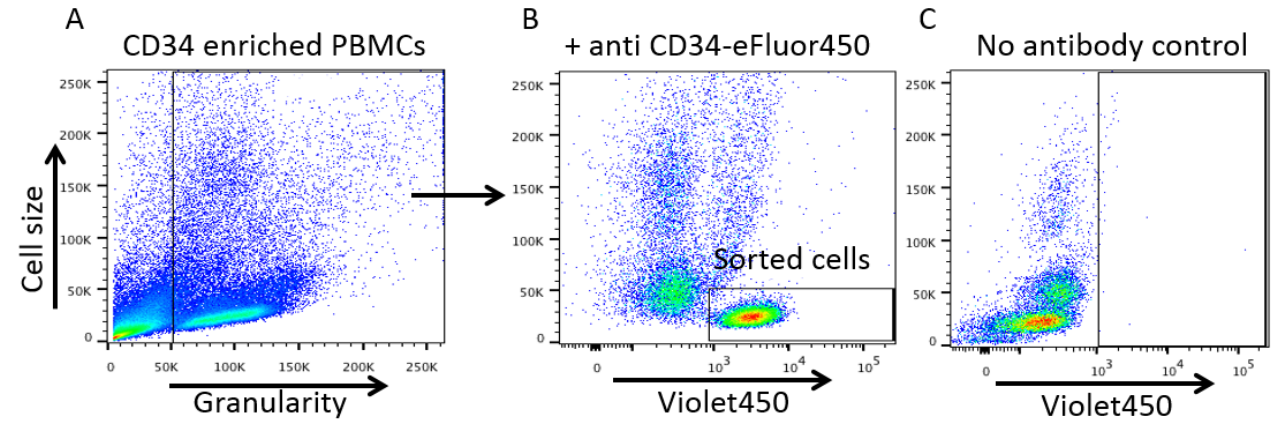
Figure 2. Anti-CD34 antibody staining identifies a clear cell population in CD34 enriched cells by flow cytometry. ( A ) Healthy cells only were gated to analyse fluorescence. ( B ) A clear cell population (black rectangle) of small cells was positive for the Violet450 fluorophore as determined by the no antibody control ( C ) where that same cell population is shifted to the left of the X-axis.